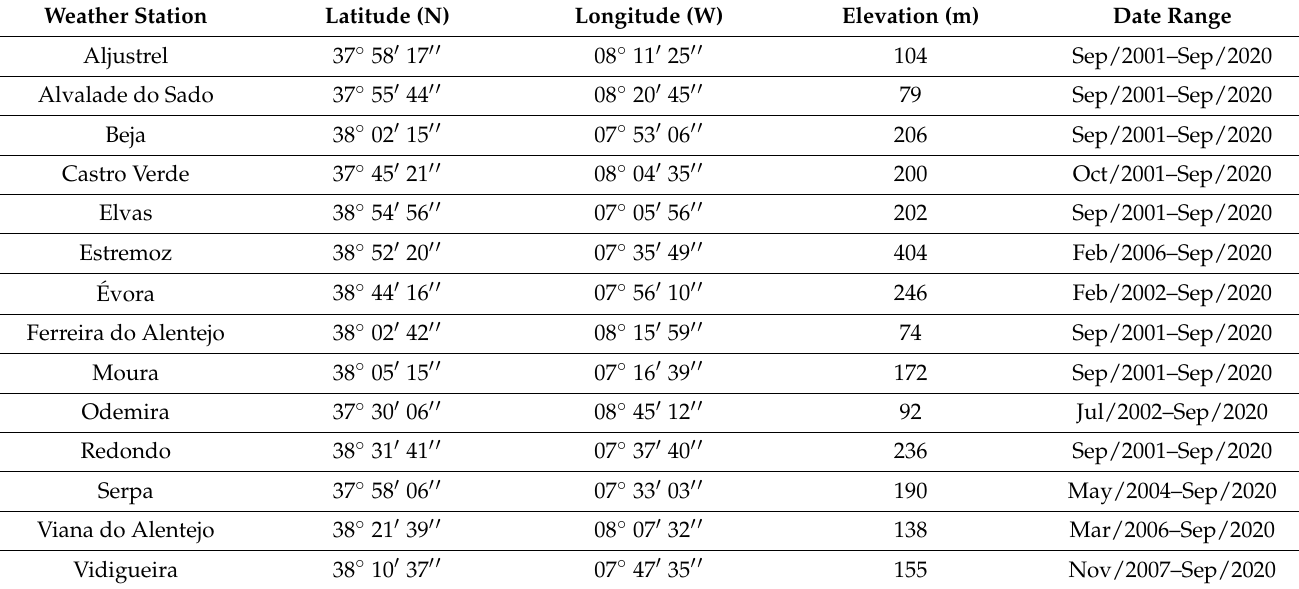
Table 1. Weather stations coordinates, elevation, distance to the sea and date ranges of the weather data series. Weather Station